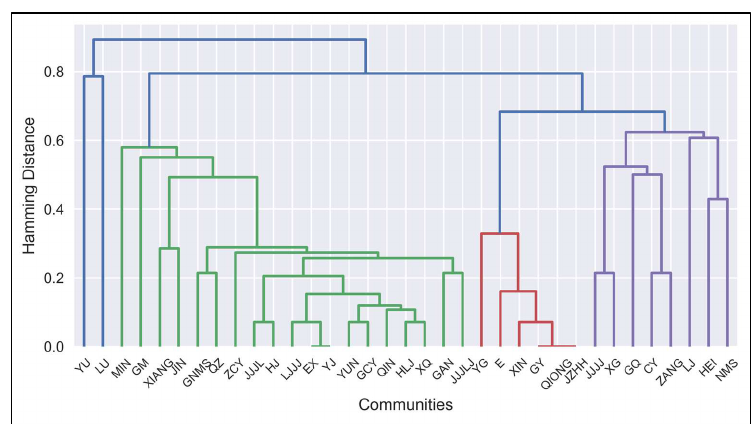
Figure 7. The dendrogram of the hierarchical clustering.